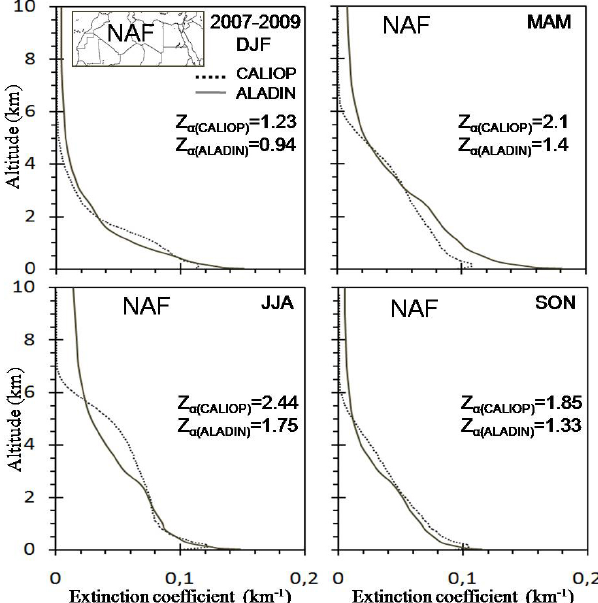
Figure 15. CALIOP and ALADIN mean seasonal extinction coef- ficient (km − 1 ) profiles (at 532 and 550nm, respectively) averaged from 2007 to 2009 over northern Africa (NAF). CALIOP profiles are shown as dark dashed lines and ALADIN profiles are shown as continuous grey lines. For each season, we give the Z α value for CALIOP and